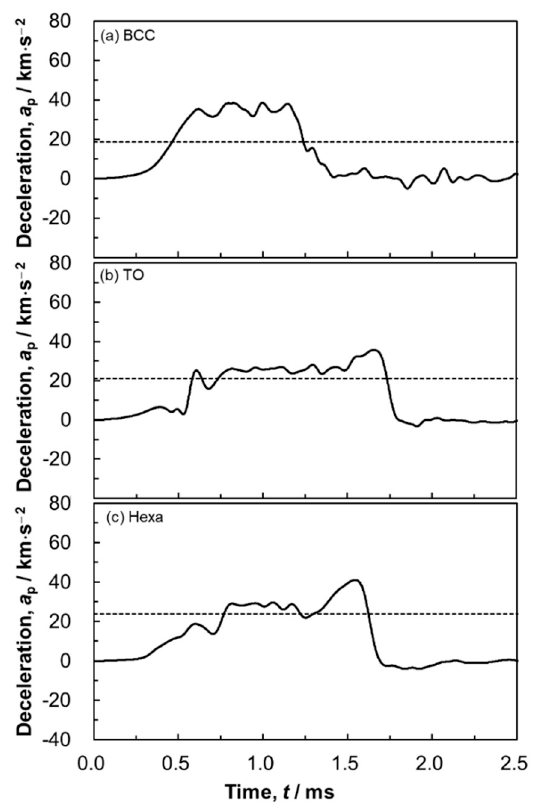
Figure 11. Change in acceleration measured by the high-speed indentation tests as a function of time: ( a ) BCC, ( b ) TO and ( c ) Hexa lattice specimens. The horizontal broken lines indicate the acceleration estimated from the plateau stress in the stress-strain curves of static indentation tests shown in Figure 10.